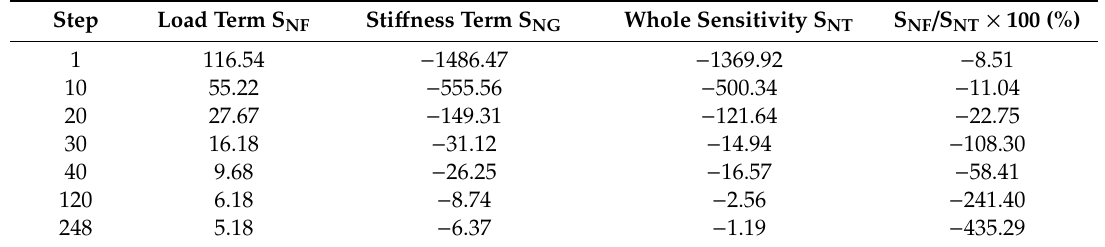
Table 1. Node 17’s strain energy sensitivity values for partial evolution steps.